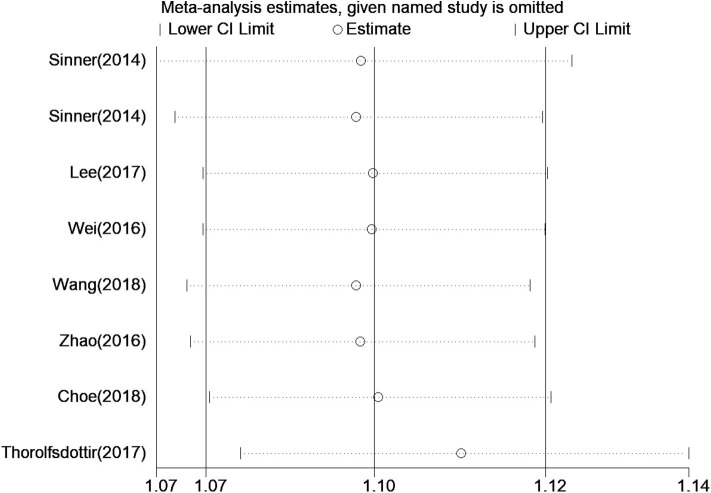
Sensitive analysis of the relationship between rs13216675 and risk of AF illustrating the influence of each study on pooled OR under the additive model. Results were computed by omitting each study in turn. Meta-analysis random-effects estimates (exponential form) were used. The two ends of the dotted lines represent the 95% CI.